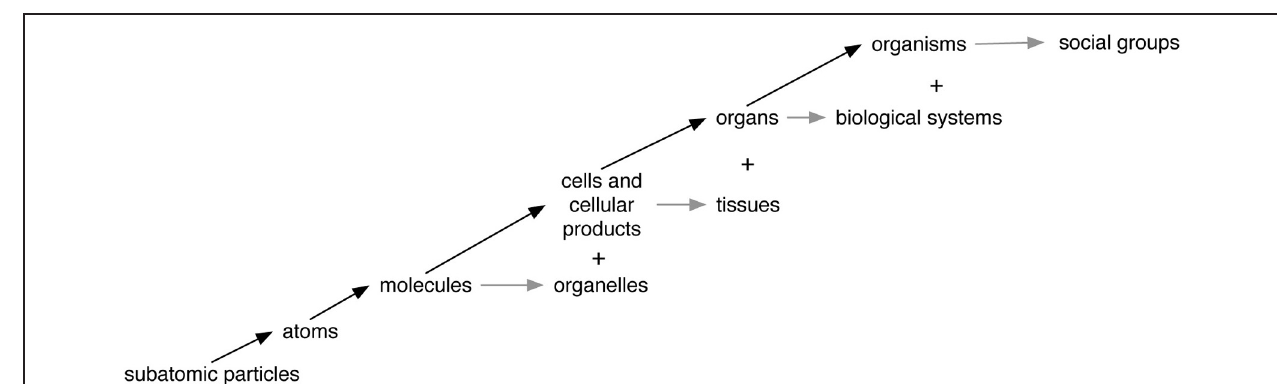
while gray arrows represent primarily functional collections of parts within a structural whole. The “+” sign indicates that lower level entities can be grouped into higher level ones in ways different from the basic part-whole